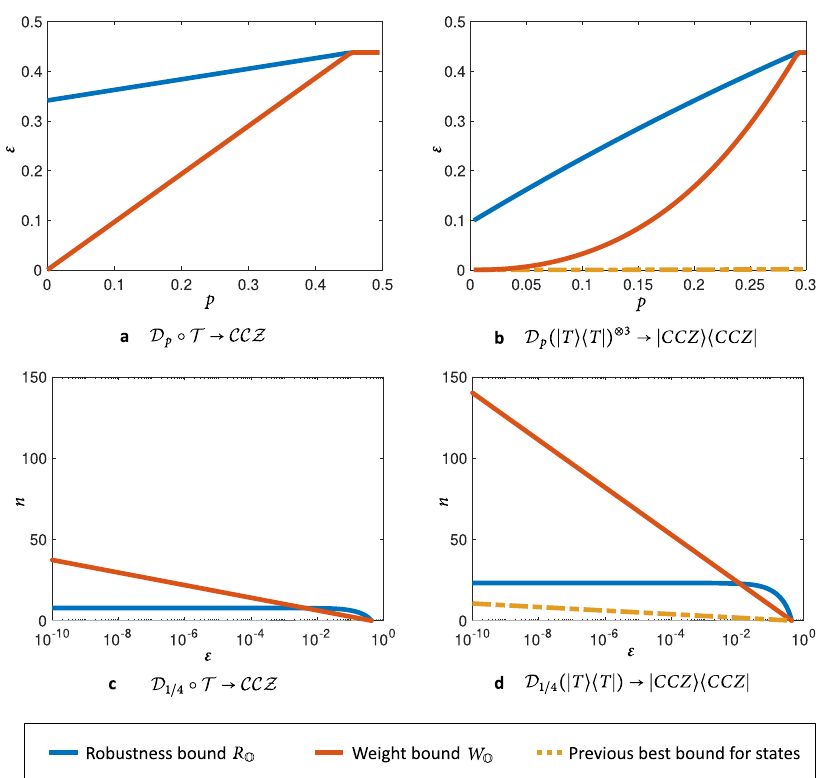
Fig. 3 Bounding the performance of gate synthesis and magic state distillation. We plot lower bounds on: a , b the error ε necessarily incurred (as per Theorem 1); c , d the number of copies necessary (as per Theorem 2) in the given transformations between the depolarised T gate/state and the depolarised CCZ gate/state. The bounds are compared with the previous best general bound for magic state distillation introduced in ref. 14 . Here, p is the noise parameter of the depolarising channel D p ð ρ Þ ¼ ð 1 (cid:3) p Þ ρ þ p 1 . In ( a ) we explicitly see that the robustness bound indicates a signi fi cant error also in 2 the noiseless case ( p = 0), whereas the weight bound becomes trivial for noiseless inputs. In ( b ) we allow three copies of the noisy T state to be used in the transformation here, both of our bounds signi fi cantly improve on the results of ref. 14 , and in particular the robustness bound reveals that an error of ≈ 0.1 is the best that one can hope for when converting T j i (cid:4) 3 ! CCZ j i with any free transformation protocol. In ( c ) and ( d ) we demonstrate the substantial advantages of the weight bound in bounding distillation overhead. Comparing the bounds for gate synthesis from the noisy T gate in ( c ) and for magic state distillation from the noisy T state in ( d ) we can see that the bounds impose much higher requirements on the number of noisy states required to